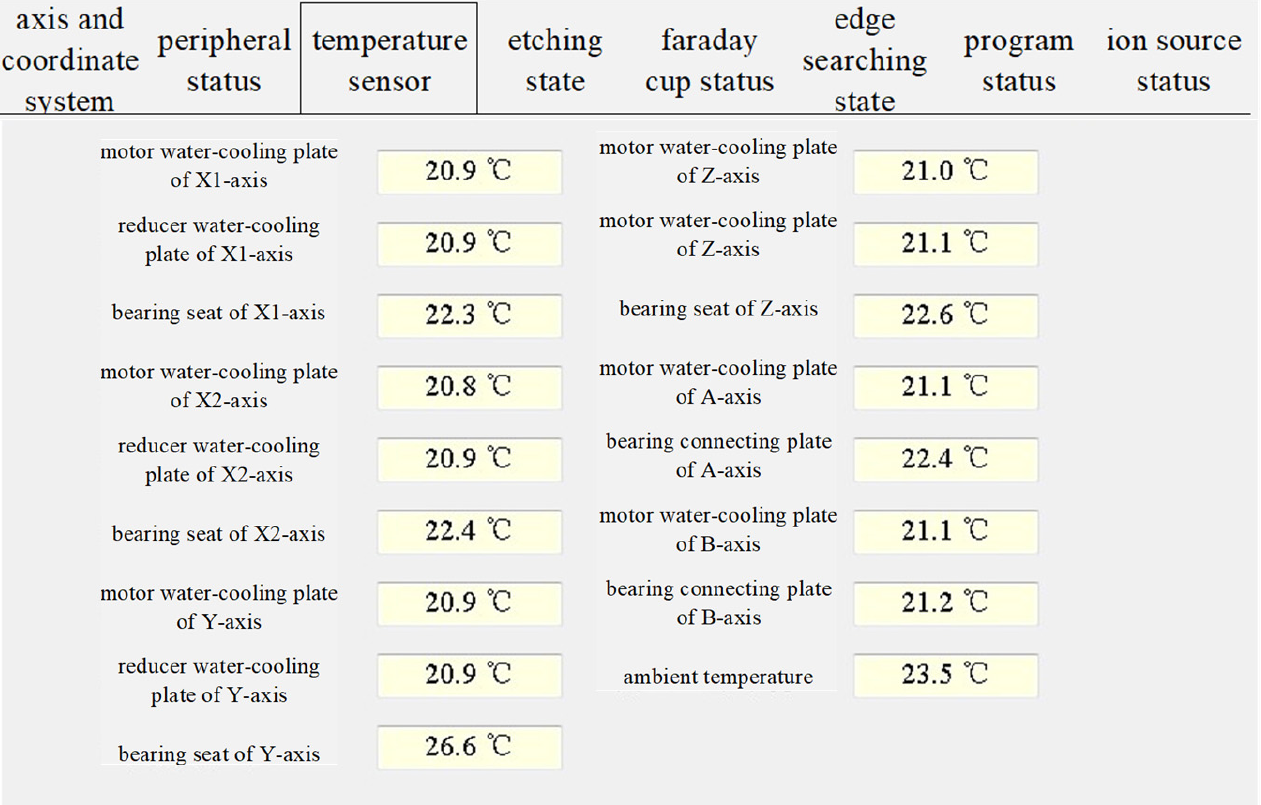
Figure 16. Positioning diagram of the temperature sensor of the Y-axis feeding system.